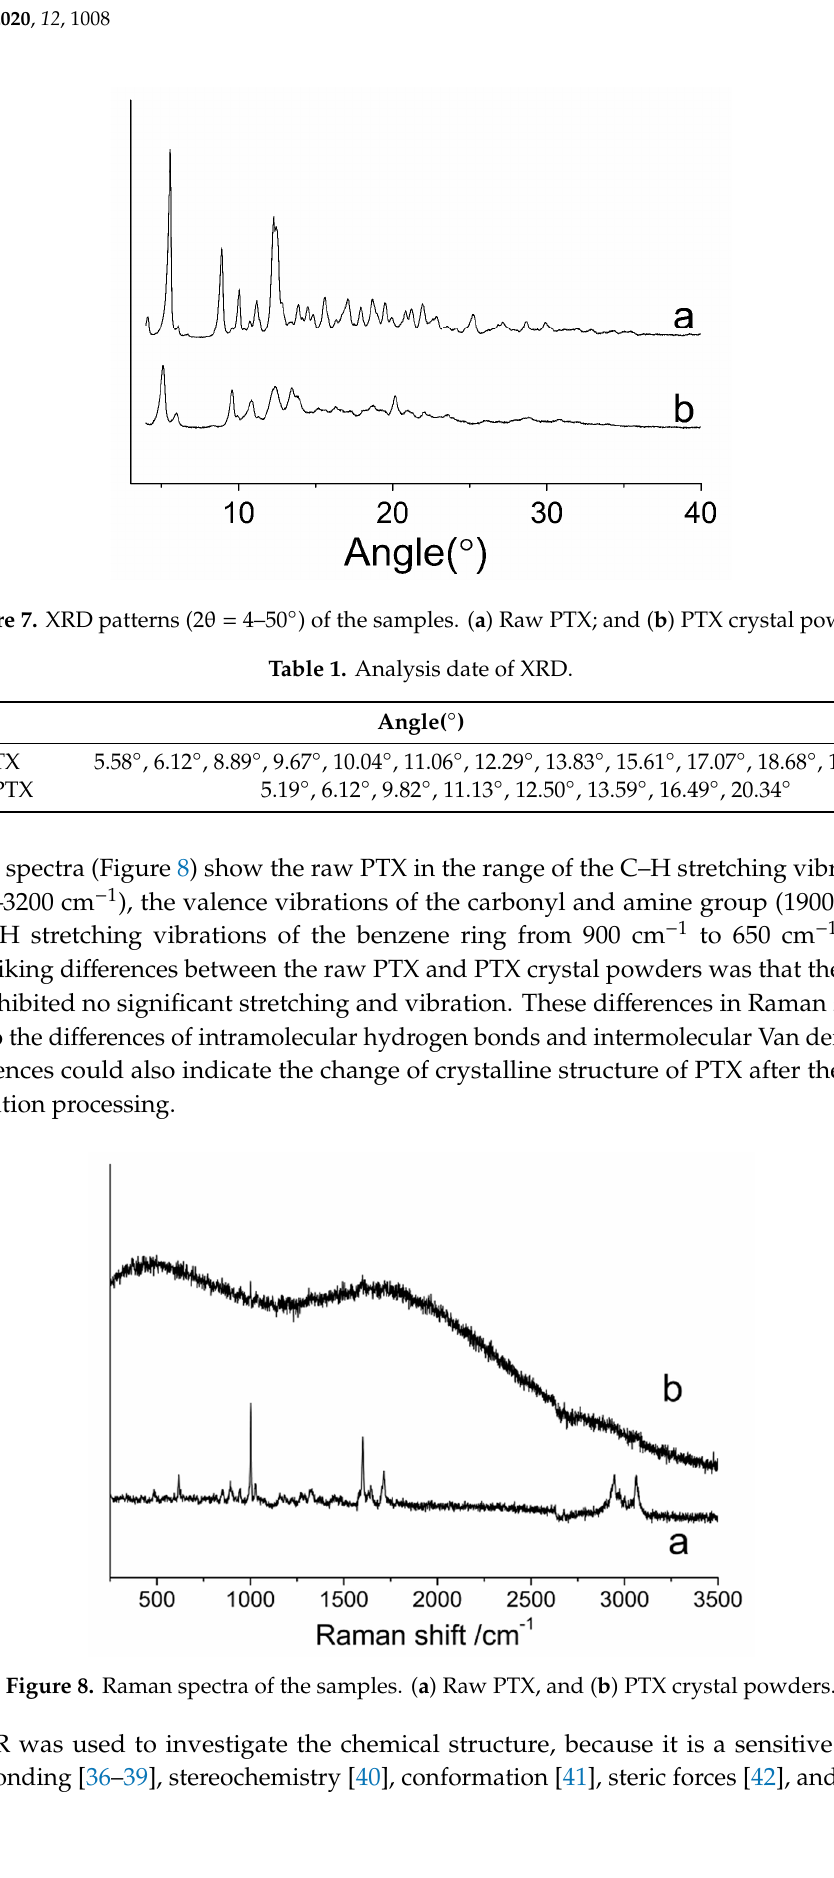
Figure 8. Raman spectra of the samples. ( a ) Raw PTX, and ( b ) PTX crystal powders.